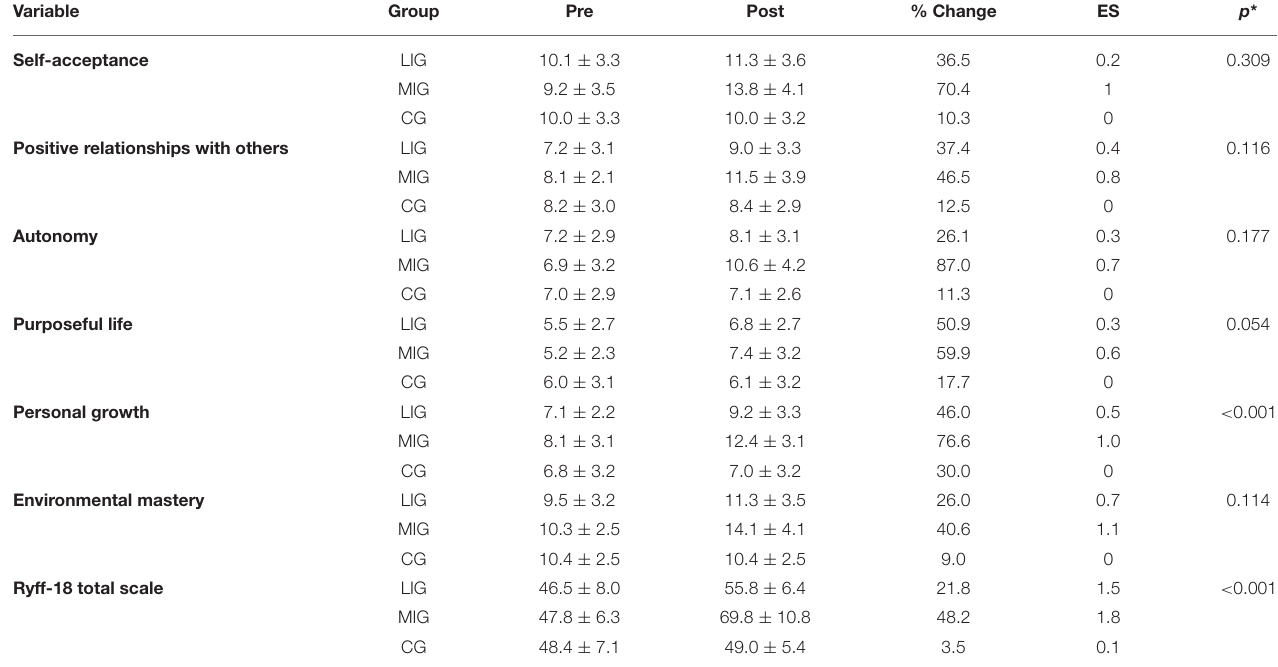
TABLE 2 | Values for psychological well-being. Variable